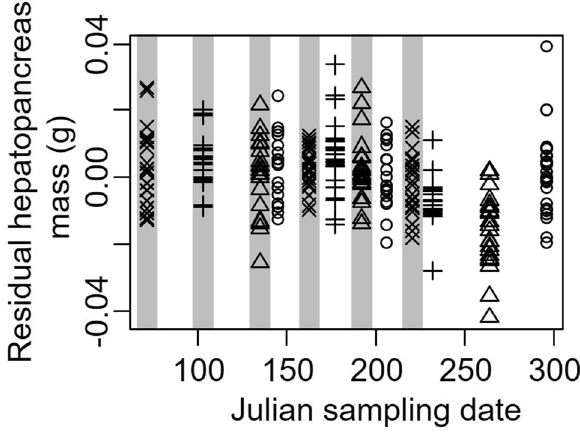
Figure 2. Residual hepatopancreas mass of Aratus pisonii (after accounting for body mass) as a function of Julian sampling date. Symbols indicate sampling site, where circles are Round Island, triangles are Oslo, plus sign is North Causeway, and the multiplication sign is Pepper park. Gray shaded sampling dates indicate periods of new moon, while white indicates full moon.